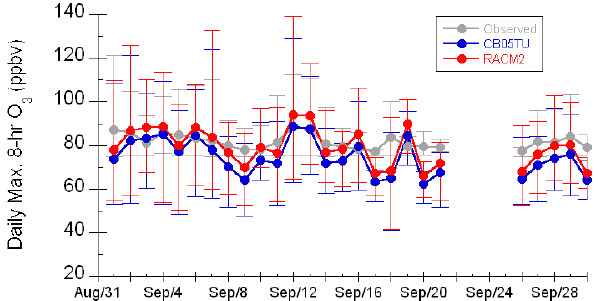
Fig. 7. A comparison of predicted daily maximum 8h O 3 with ob- servations from the Air Quality System (when 8h O 3 >75ppbv). Error bars represent minimum and maximum